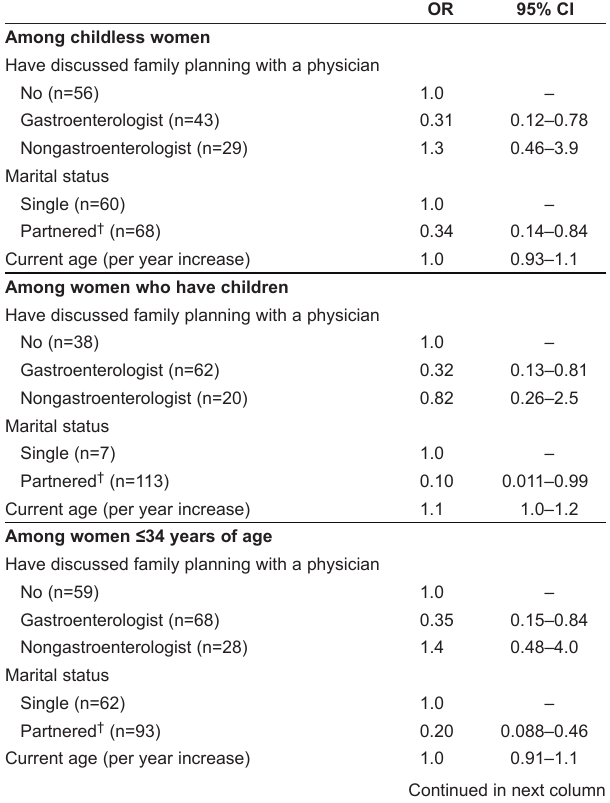
TABLE 6 Multivariable logistic regression model for estimating the effect of having discussed family planning with a